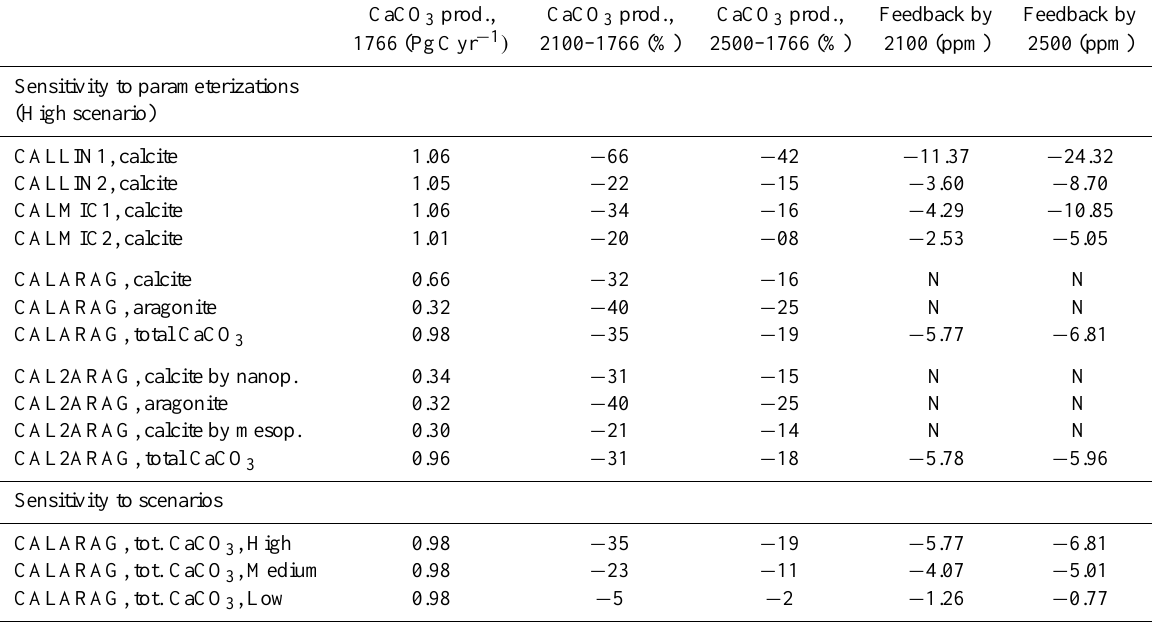
Table 3. Sensitivity of CaCO 3 production and of the CO 2 -CaCO 3 production/dissolution feedback to different parameterizations and emis- sion pathways. Emissions follow the High, Medium and Low scenario over the 21st century and are set to zero after 2100. N = not